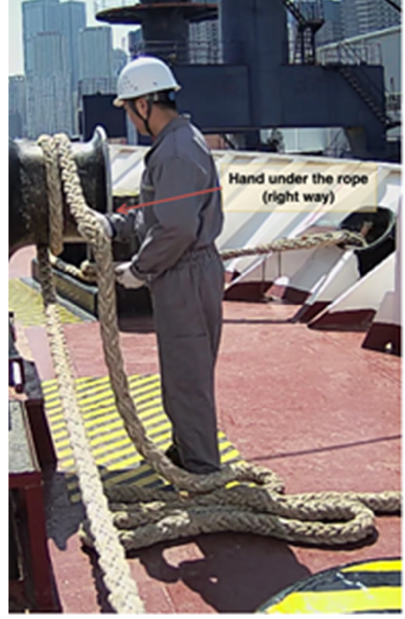
Figure 4. A crew member utilizing a mooring rope.